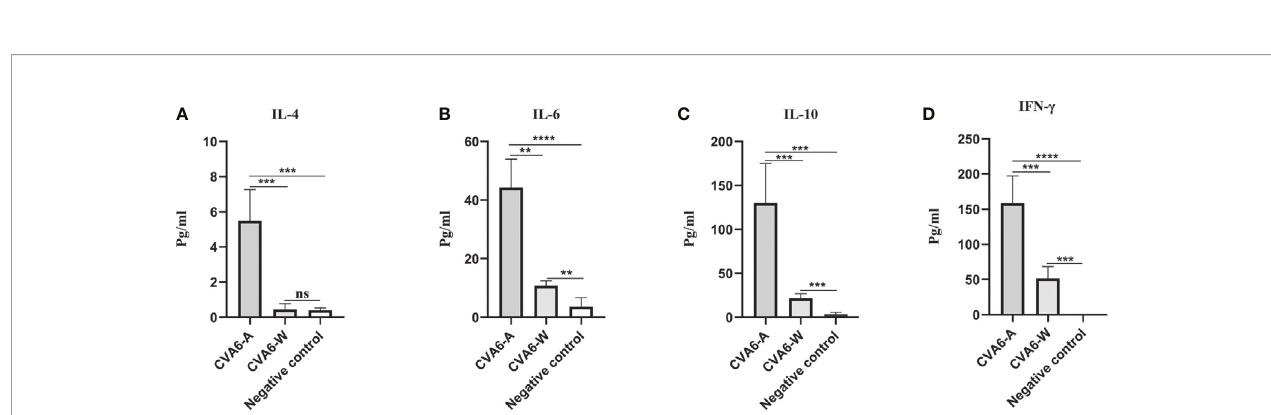
FIGURE 4 | Cytokine expression in the coxsackievirus A6 (CVA6)-A and CVA6-W infected mice. Here, 10-day-old suckling mice were inoculated with a similar load of CVA6-A and CVA6-W. The expression levels of IL-4 (A) , IL-6 (B) , IL-10 (C) , and IFN- g (D) were detected by using enzyme-linked immunosorbent assay from the serum of the post-infected CVA6-A and CVA6-W 4 d.p.i. (n = 3). **p < 0.01, ***P < 0.001, ****P < 0.0001, n.s., insigni fi cant